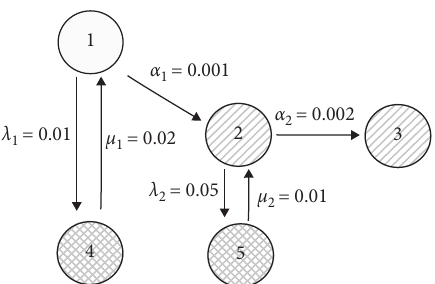
Figure 4: State transition diagram of the example without